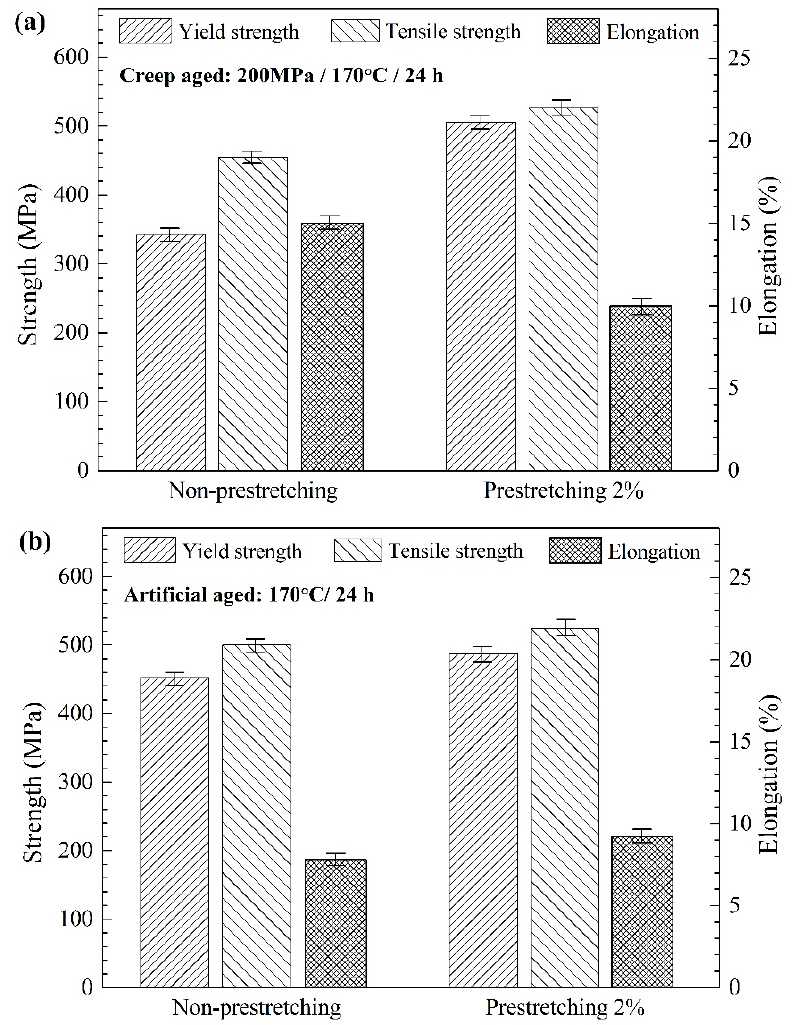
Figure 3. Comparison of mechanical properties of AA2195 specimens with different pre-stretching states after the process of: ( a ) creep aging and ( b ) artificial aging.